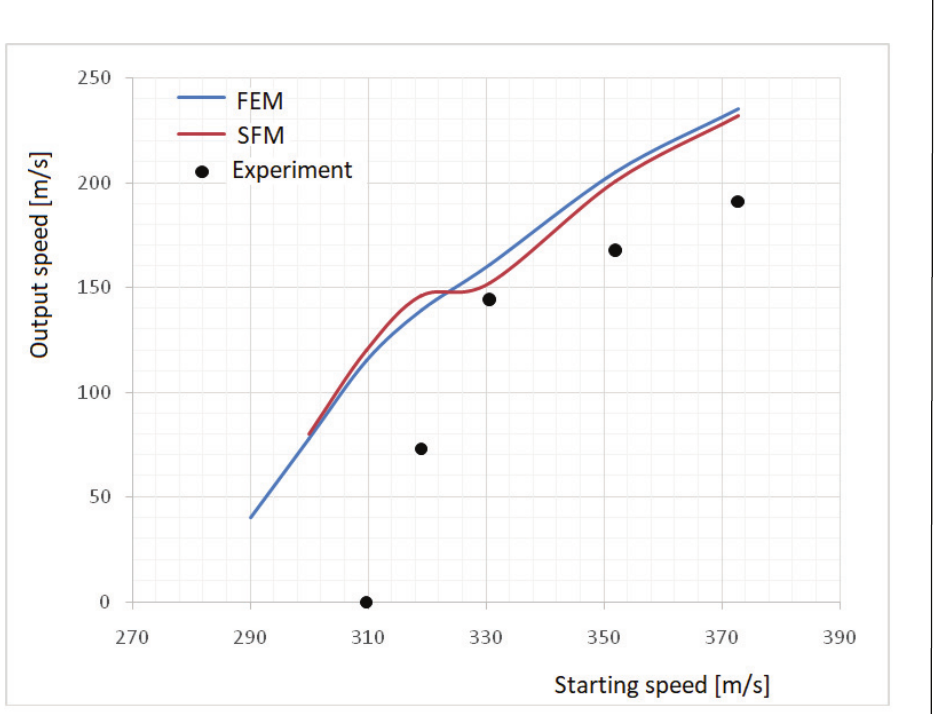
Figure 28 – Comparison of the results obtained with the FEM and SFM methods for an aluminum plate with a thickness of 30 mm, conical